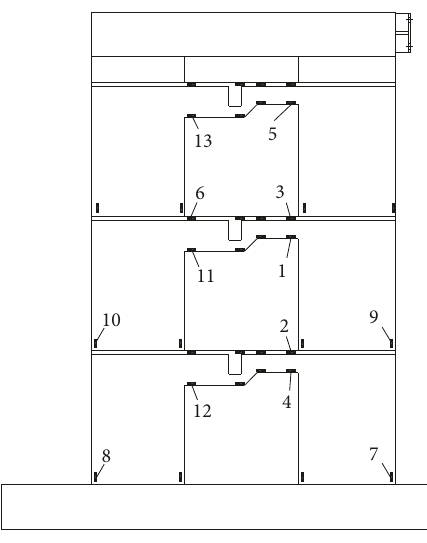
Figure 10: Yielding process (numbers represent yield order).